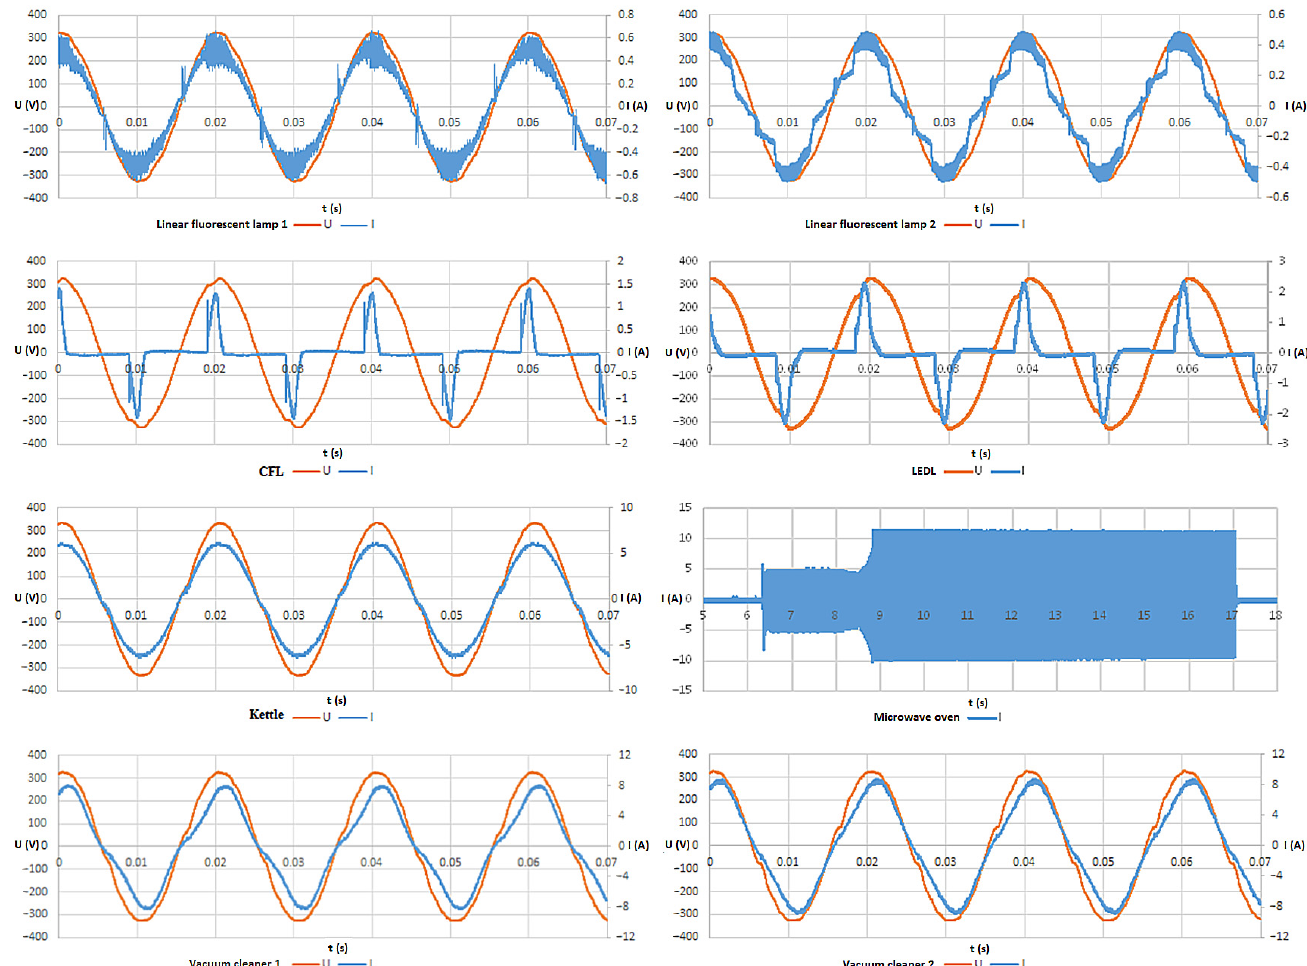
Figure 4. Voltage and current measured during measurement of operation of individual tested appliance combinations (the voltage is presented by the orange lines and the current by the blue lines; the voltage values are presented in volts and the current value in amperes.